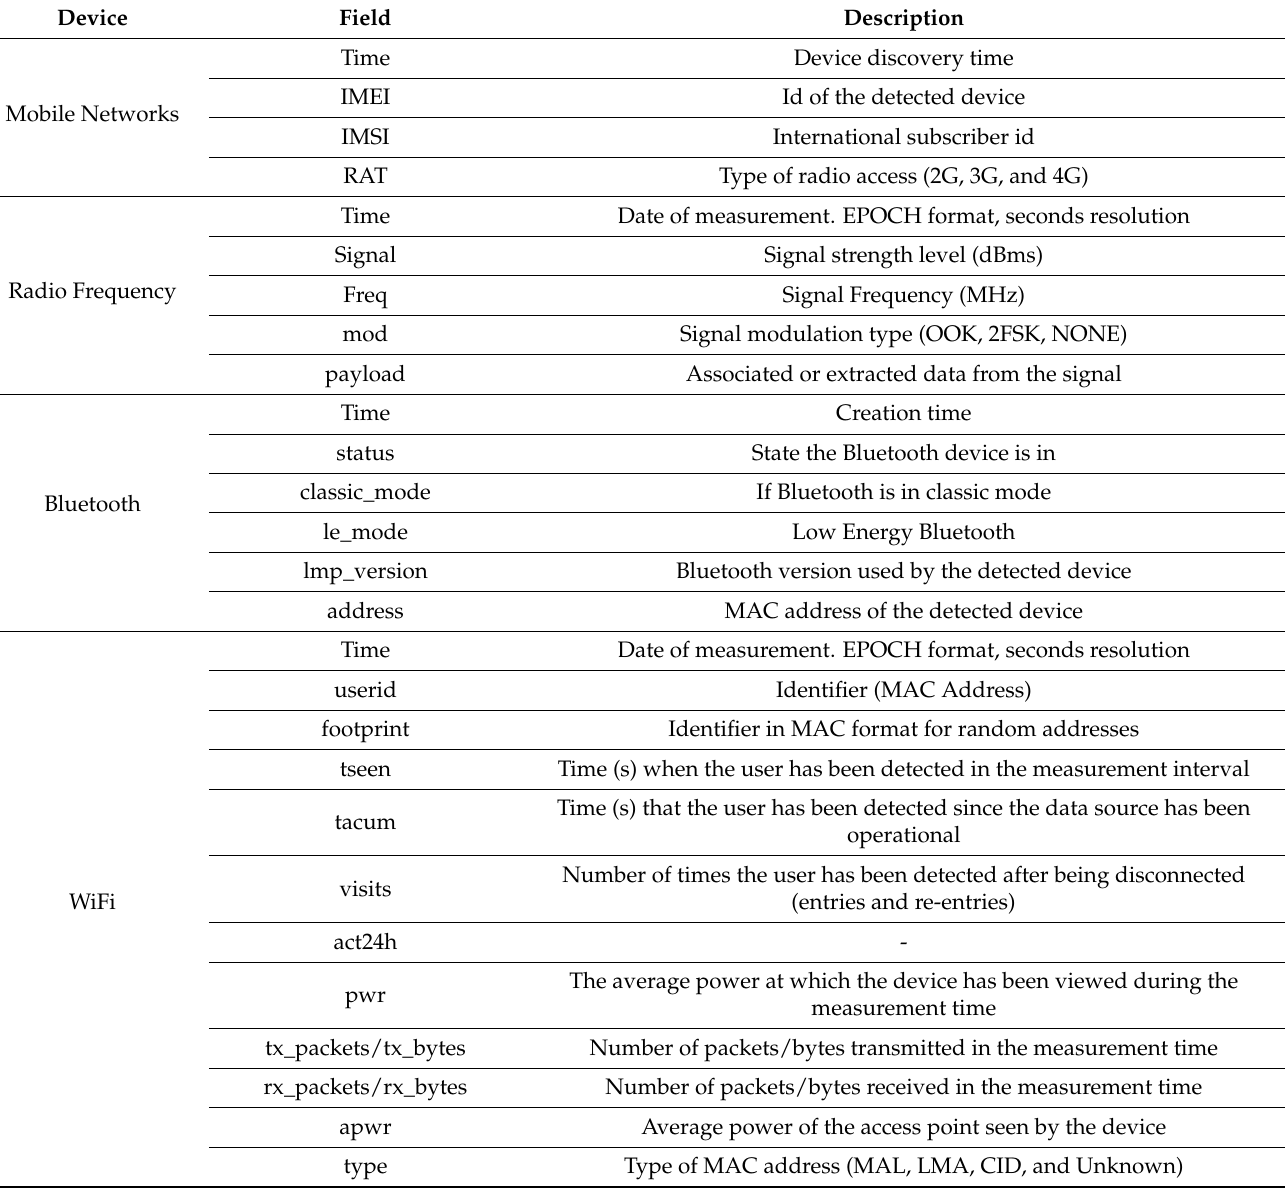
Table 1. Data fields from each data